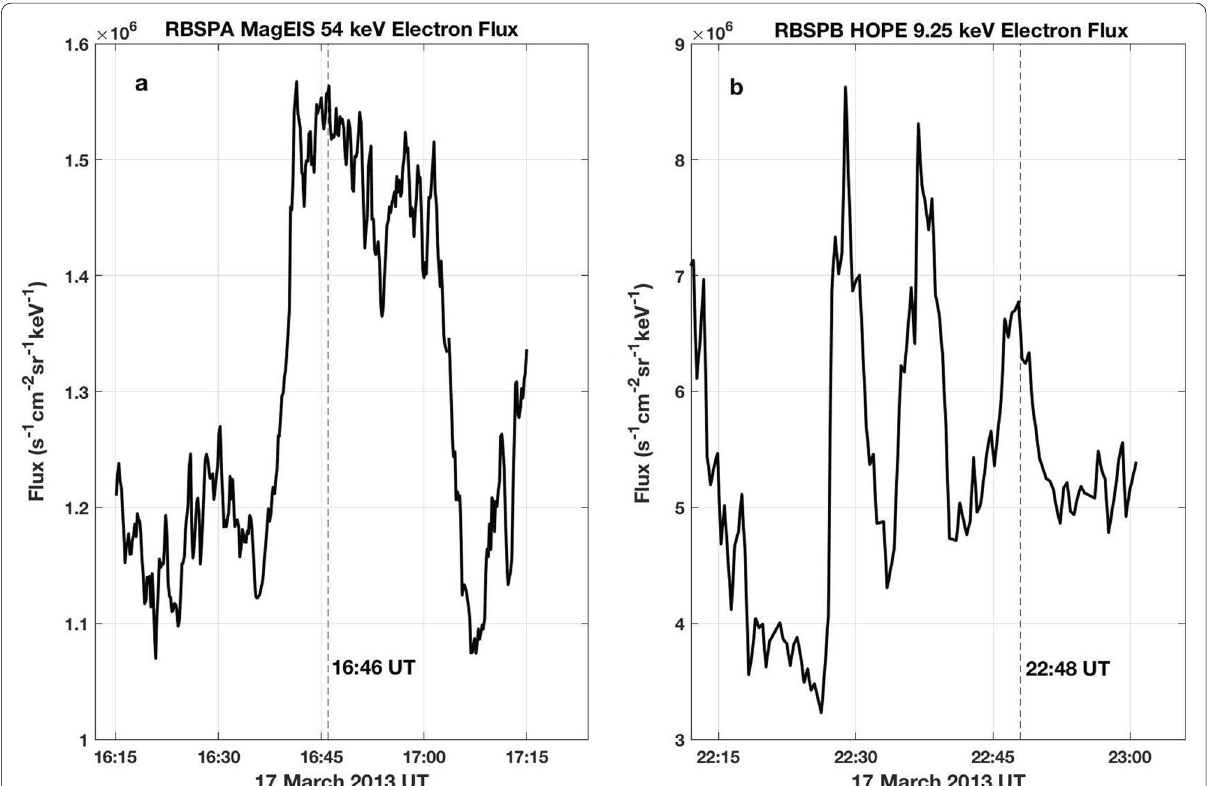
Fig. 5 Sharp electron injections occurred at the ( n Fig. 2 ( a MagEIS 54-keV electrons) and Fig. 4 ( b HOPE 9.25-keV electrons). The observation times of the chorus rising tones are indicated by dashed